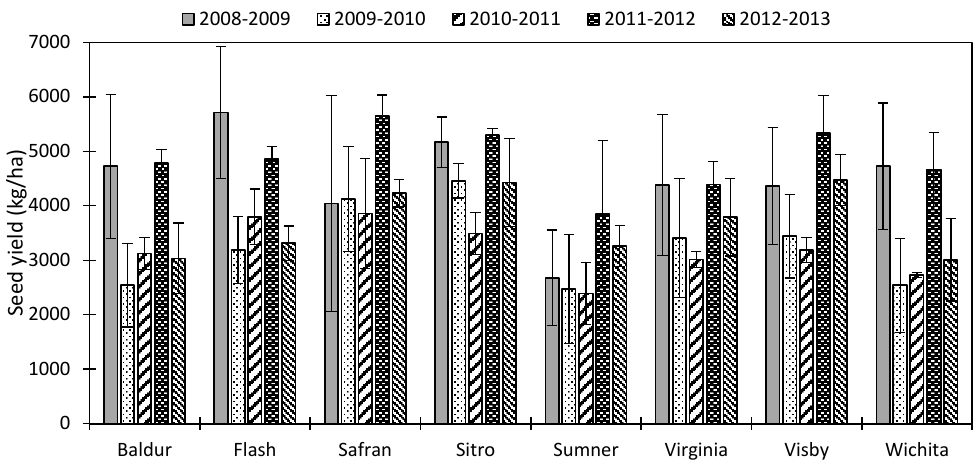
Figure 3. Average and standard deviation of winter canola seed yield for the 2008 – 2013 period.